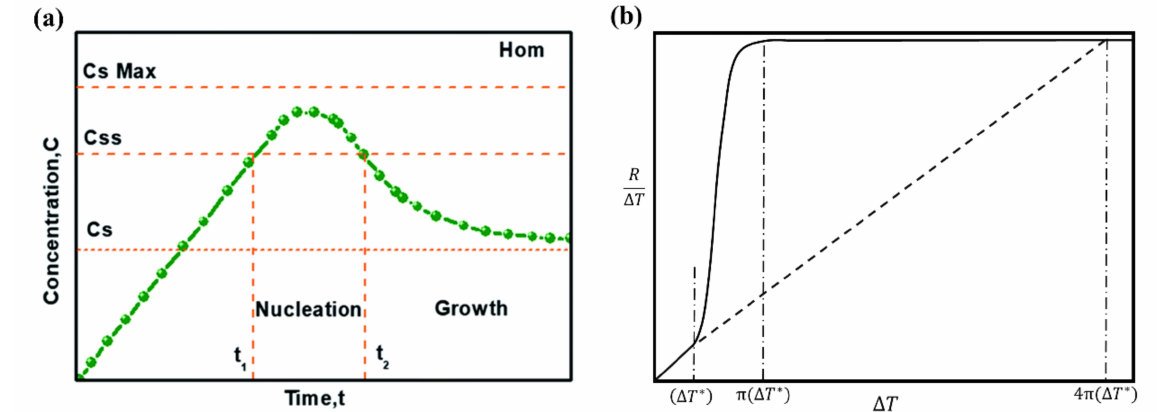
Figure 3. ( a ) LaMer diagram depicting the nucleation and growth dynamics. (Reprinted with permission from Ref. [44]. Copyright 1950 American Chemical Society). ( b ) Theoretically predicted growth rate curve for surfaces. Reprinted with permission from Ref. [47]. Copyright 1964 Elsevier